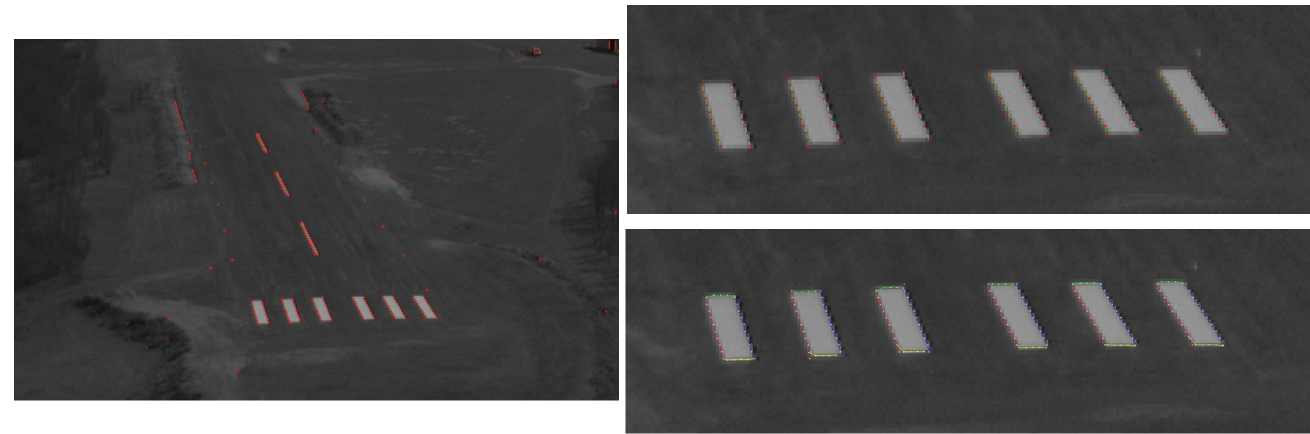
Figure 3. Runway area of the grayscale image, all steps done on the whole image. Vertical edges ( left ) and line chains to quadrangles ( right ). Horizontal edges and chains are also